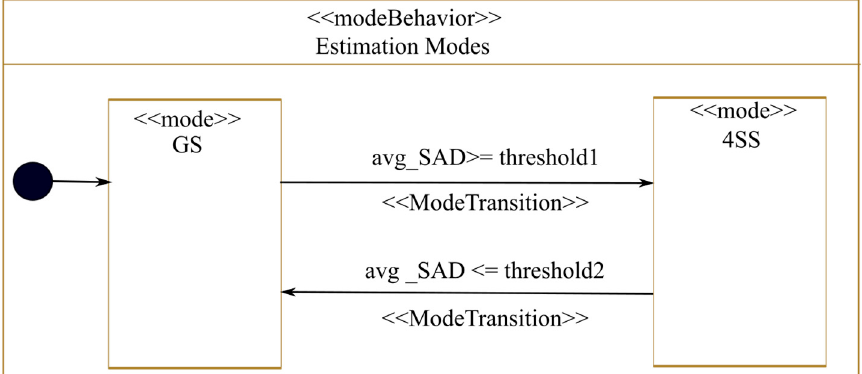
Figure 12. Reconfiguration controller modes.